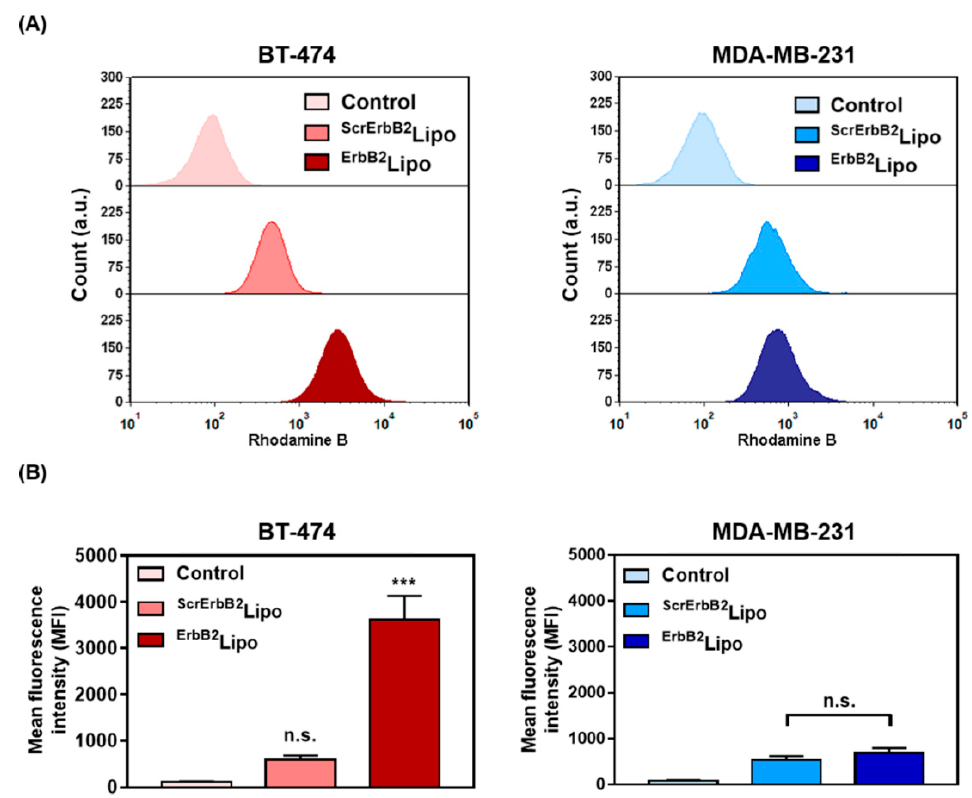
Figure 4. Analysis of binding between rhodamine B-labeled liposomes and breast cancer cells using flow cytometry. BT-474 and MDA-MB-231 cells were treated with control, ScrErbB2 Lipo, and ErbB2 Lipo. ( A ) Plots of flow cytometry results and ( B ) quantitative analysis of Figure 4A.